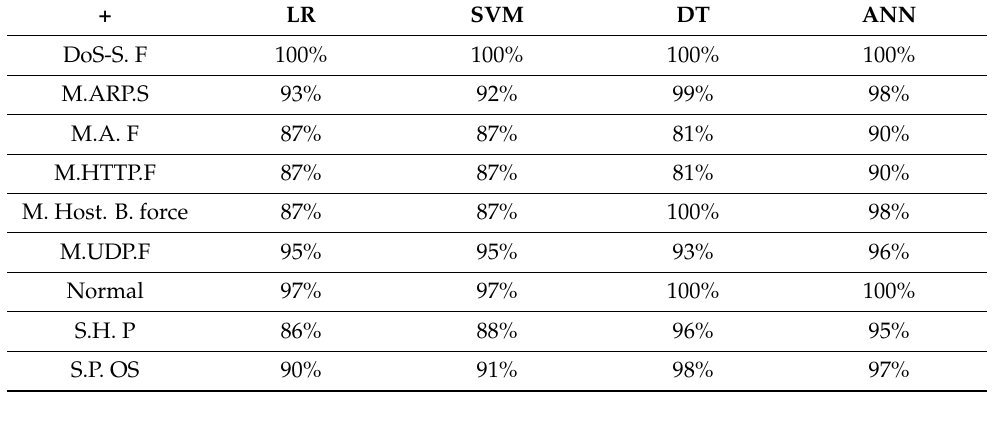
Table 6. Performance of various ML algorithms relative to the various attack type and normal.